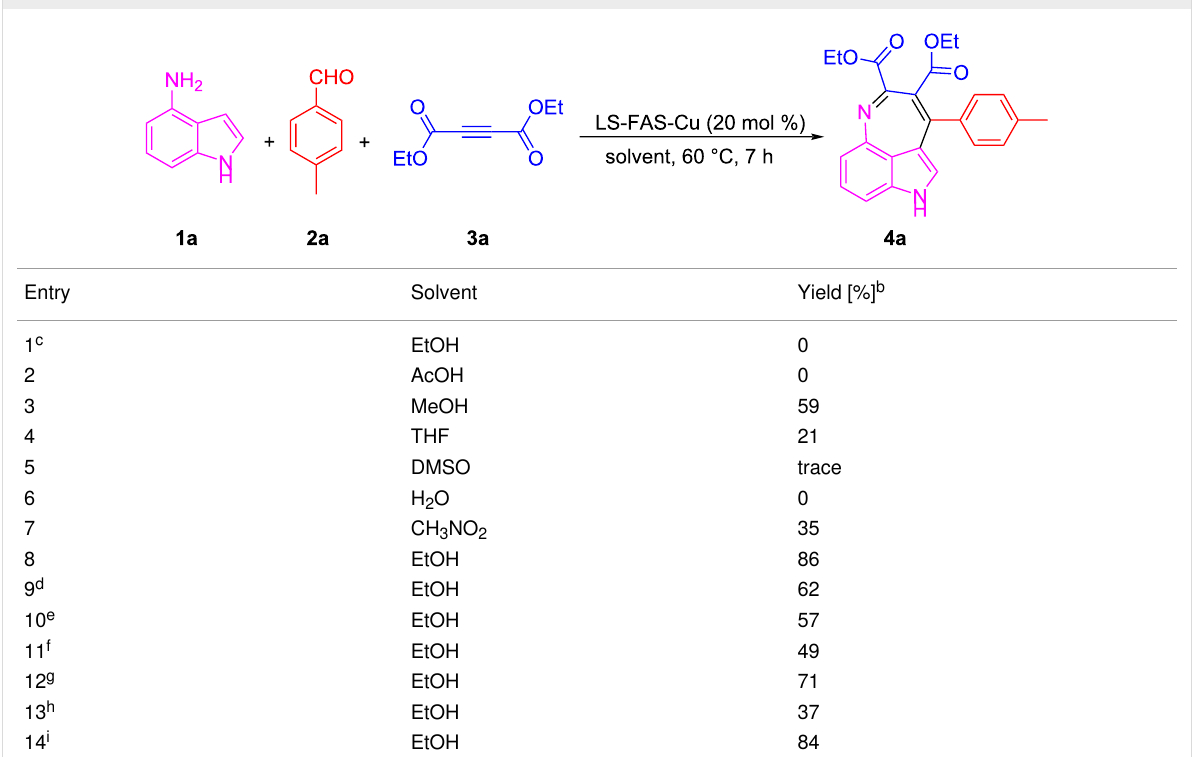
Table 1: Three-component reaction of 1a , 2a , and 3a to synthesis of 4a a